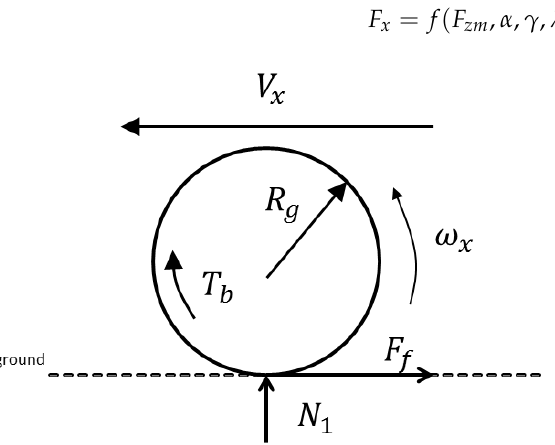
Figure 2. Aircraft landing roll force.